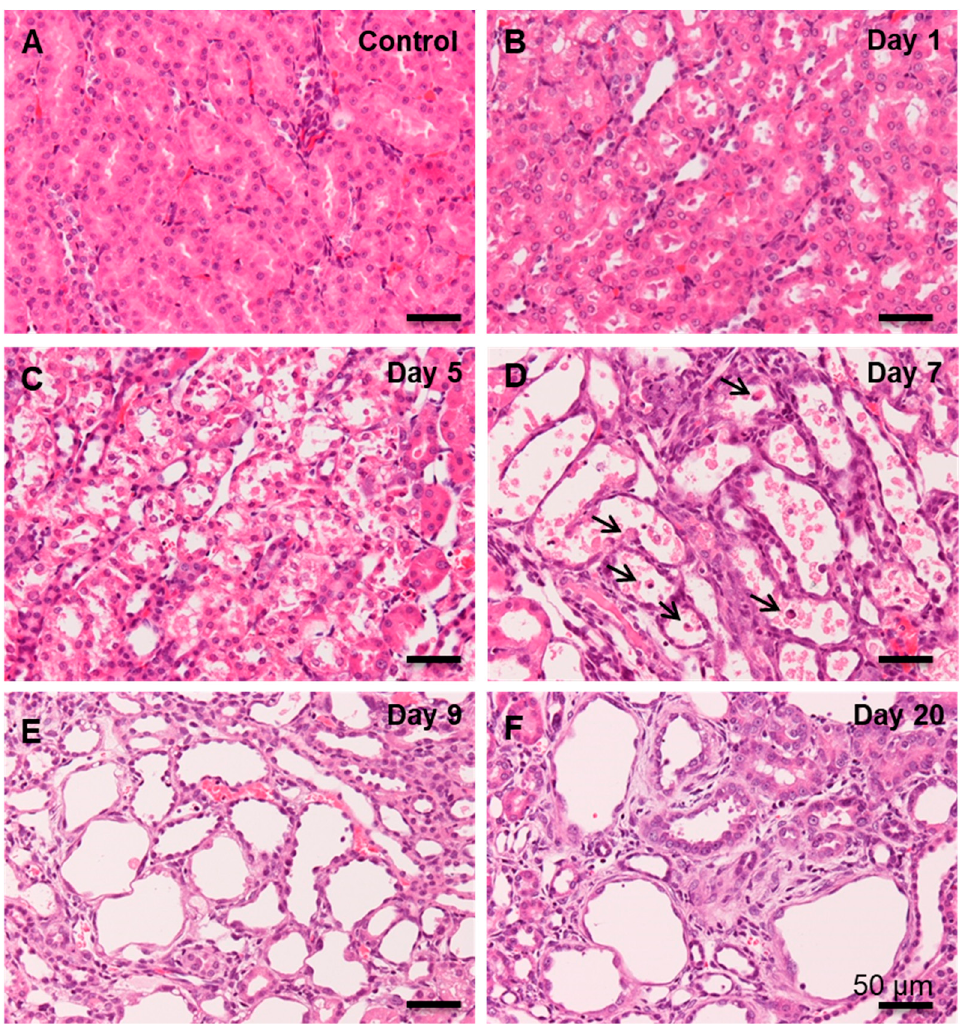
Figure 1. Histopathology of cisplatin (CDDP)-induced rat renal lesions. ( A ) In the control kidneys (fibrosis degree, − ), no significant change is observed. ( B ) On day 1 (fibrosis degree, − ) following CDDP injection, renal proximal tubular epithelial cells in the corticomedullary junction show nuclear alterations. ( C ) On day 5 (fibrosis degree, 1+), the renal proximal tubular epithelial cells show swelling and desquamation. ( D ) On day 7 (fibrosis degree, 2+), the affected tubules are dilated, showing complete desquamation, and lined partly by regenerating epithelial cells; infiltration of inflammatory cells (arrow) are seen in the injured lumina. ( E ) On day 9 (fibrosis degree, 3+), fibrosis is observed in the interstitium around the affected tubules with variously dilated lumen. ( F ) On day 20 (fibrosis degree, 4+), the damaged renal tubules lined by incompletely regenerating epithelial cells and fibrosis are seen around these tubules. HE stain, bar = 50 µm.